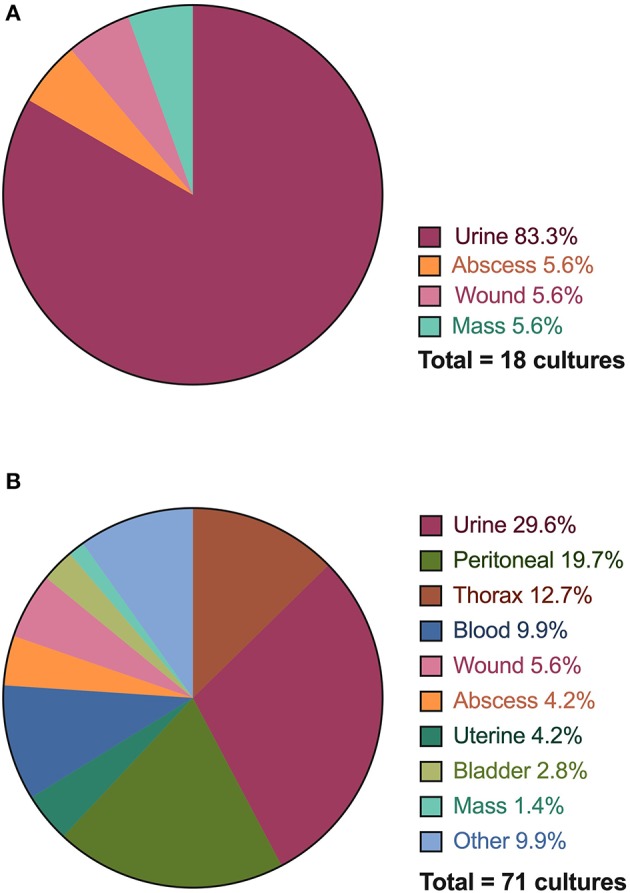
Distribution of anatomical sites and specimens collected for bacterial culture and susceptibility testing performed for Emergency Room (ER) outpatients (A) and Critical Care (CC) inpatients (B). The thorax category includes both pleural cavity and lung aspirate samples.